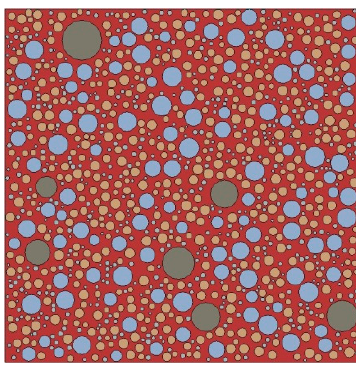
Figure 4. 2D RCA model.